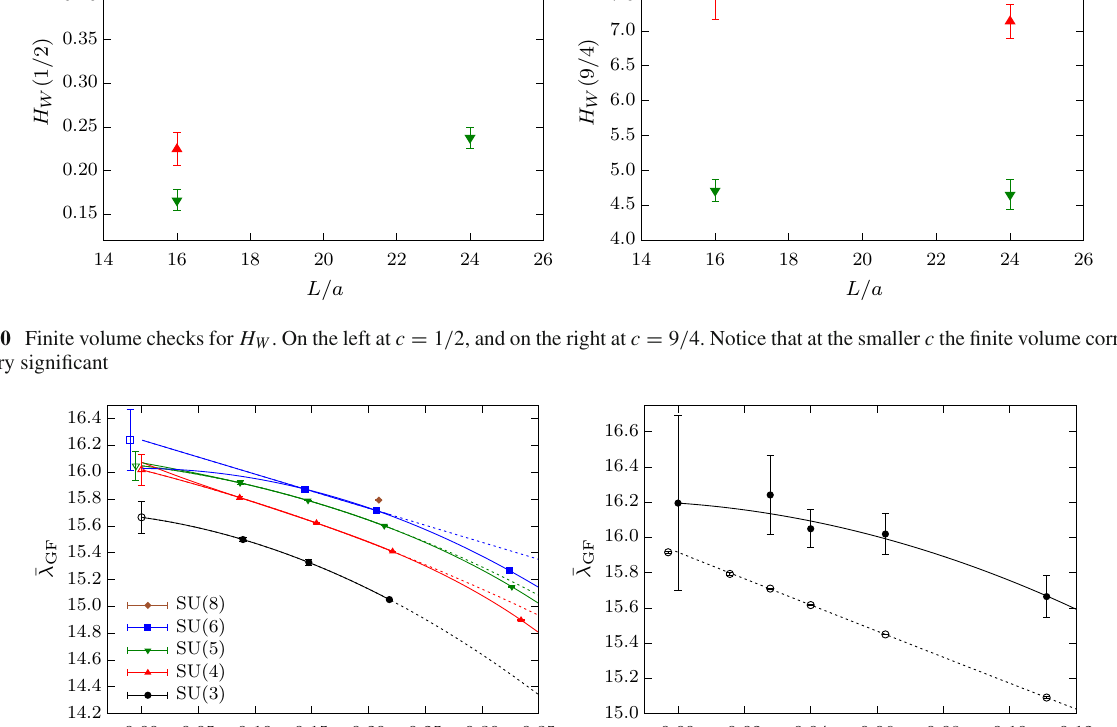
is an excellent agreement between the data and the expected scaling in powers of 1 / N 2 . The points at finite lattice spacing have been slightly shifted for better